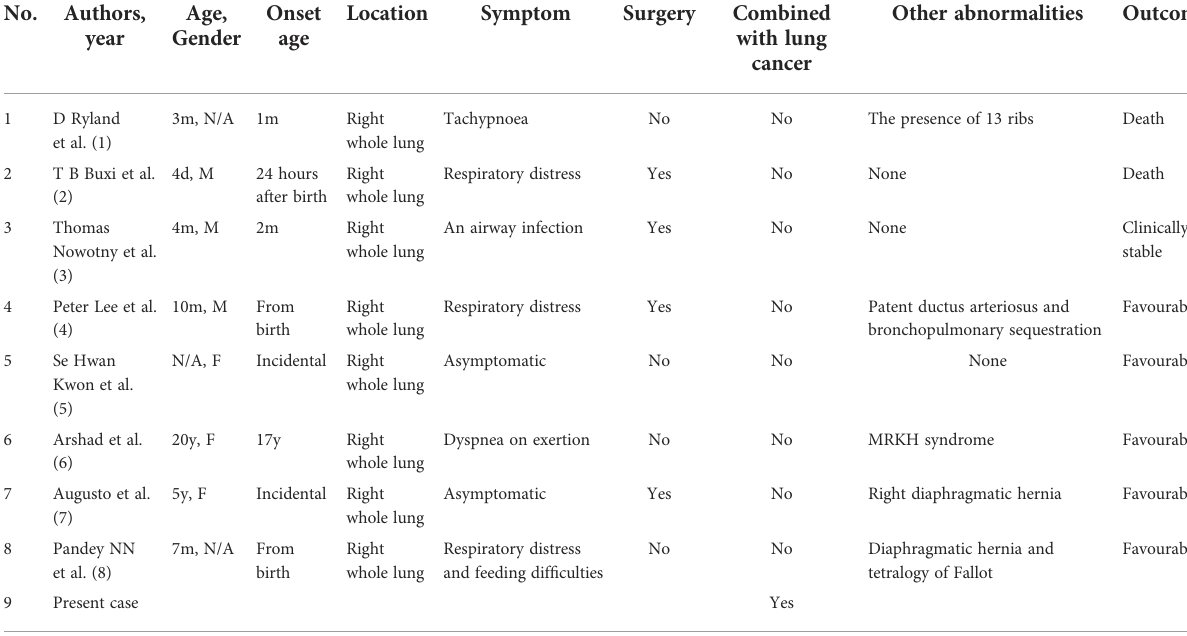
TABLE 1 Summary of right pulmonary aplasia of the